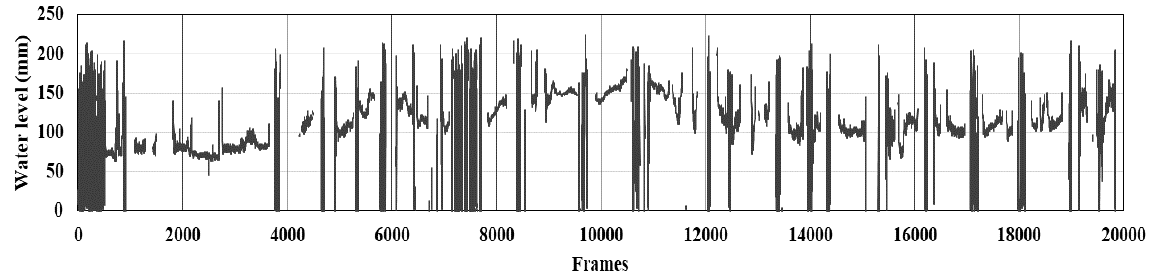
Figure 4. Water level per frame of CCTV Figure 3. Water level per frame of CCTV footage.